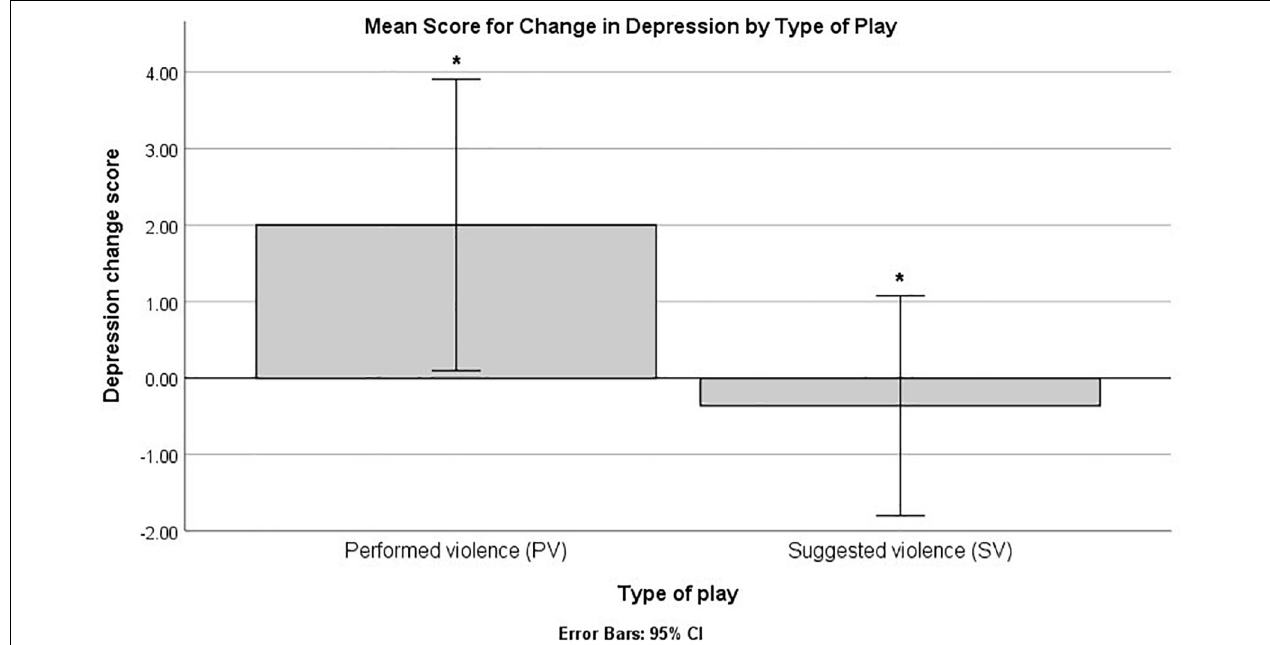
FIGURE 1 | Mean scores for depression change scores by type of play. The bars marked by “*” indicate statistically significant differences based on a non-parametric analysis and B–H procedure for controlling false discovery rate (FDR).